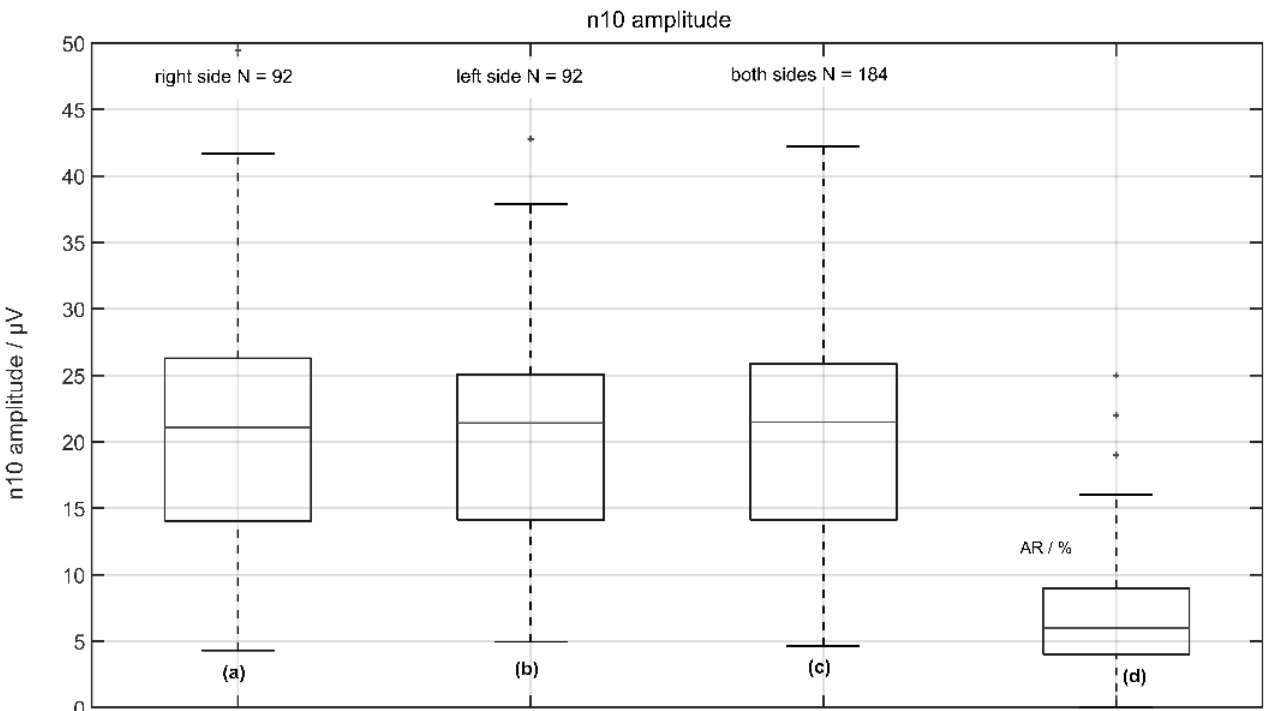
Figure 3. Normative data of n10 amplitude from 92 volunteers: ( a ) the response of the left side (right measured); ( b ) the response of the right side (left measured); ( c ) the response from left and right sides; and ( d ) the asymmetric ratio (AR) of n10 amplitudes.